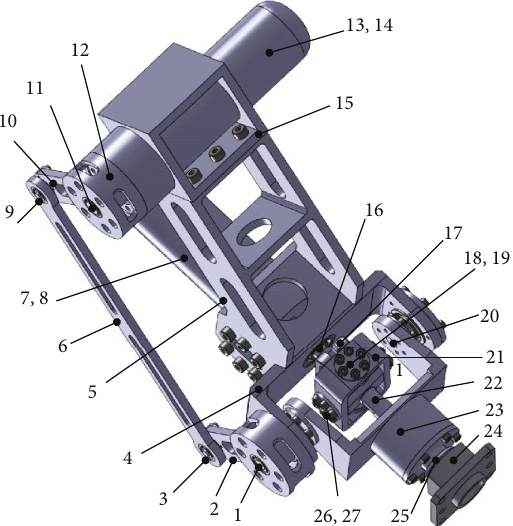
Figure 7: A novel biomimetic robotic elbow joint virtual prototype. 1, 3, 9, 11, 16, 18, 19, 20, 25, 26, and 27 — revolute joints; 2 and 10 — short bars; 4 — frame; 5 — upper arm; 6 — long bar; 7 and 13 — motor; 8 and 14 — connectors; 12 – 15 — motor bases; 17 and 23 — connecting rods; 21 — annular member; 22 — moving platform; and 24 — arm connector.